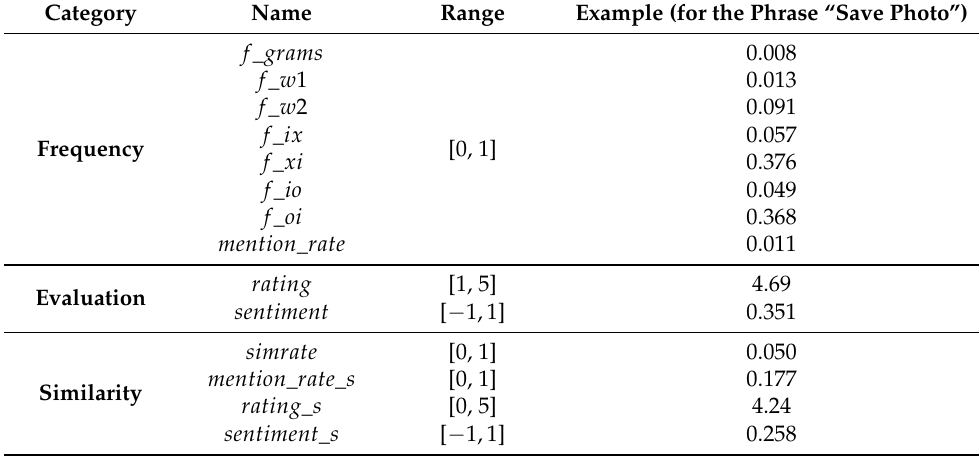
Table 2. Feature summary for